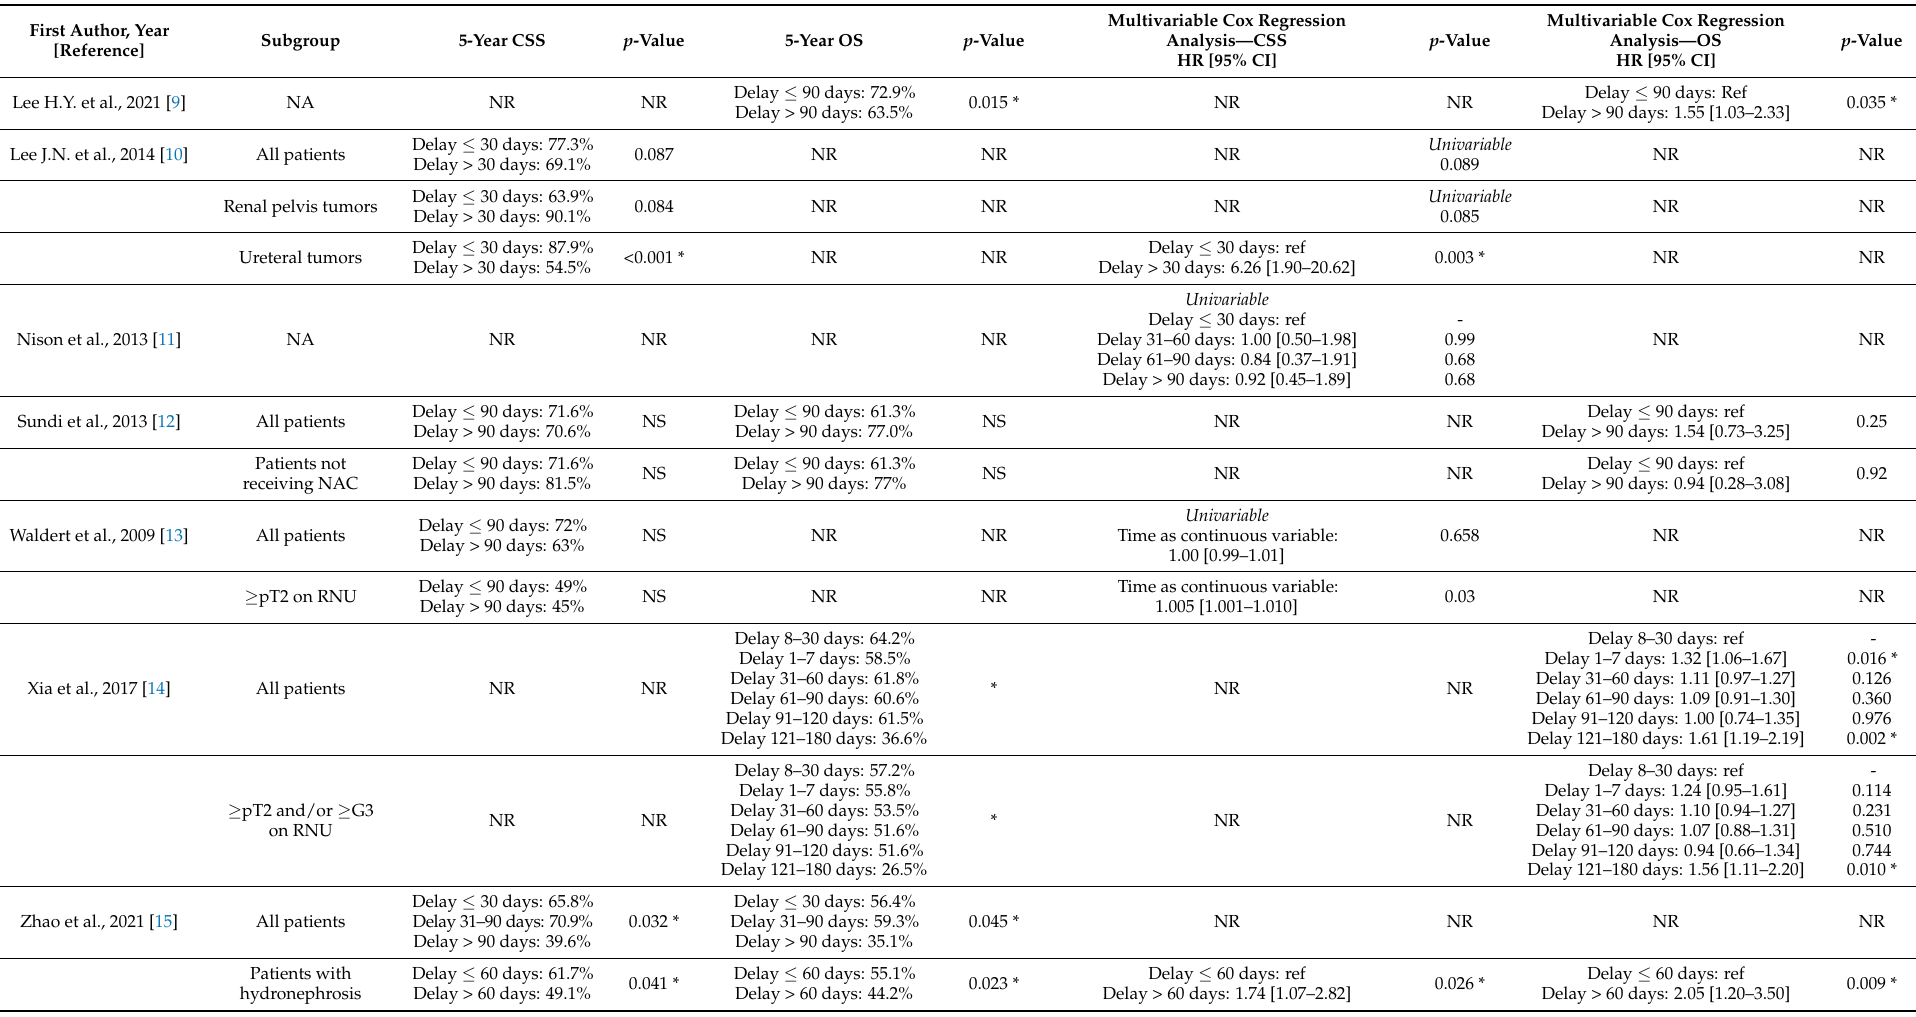
* Statistically significant p -value. Abbreviations: CI = confidence interval; CSS = cancer-specific survival; HR = hazard ratio; OS = overall survival; NA = not applicable; NR = not reported; NS = not statistically significant; RNU = radical